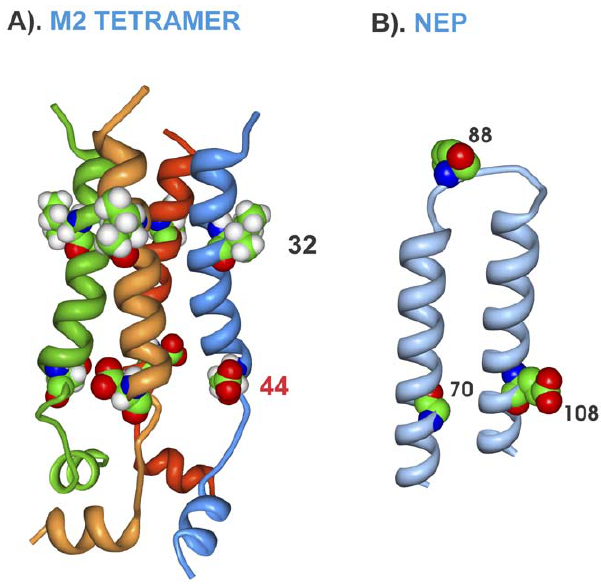
Figure 9. M2 tetramer and NEP three dimensional maps of mouse adaptive mutations. Mutations are shown as described in Fig. 3. (A) on the M2 tetramer and (B) the NEP protein.